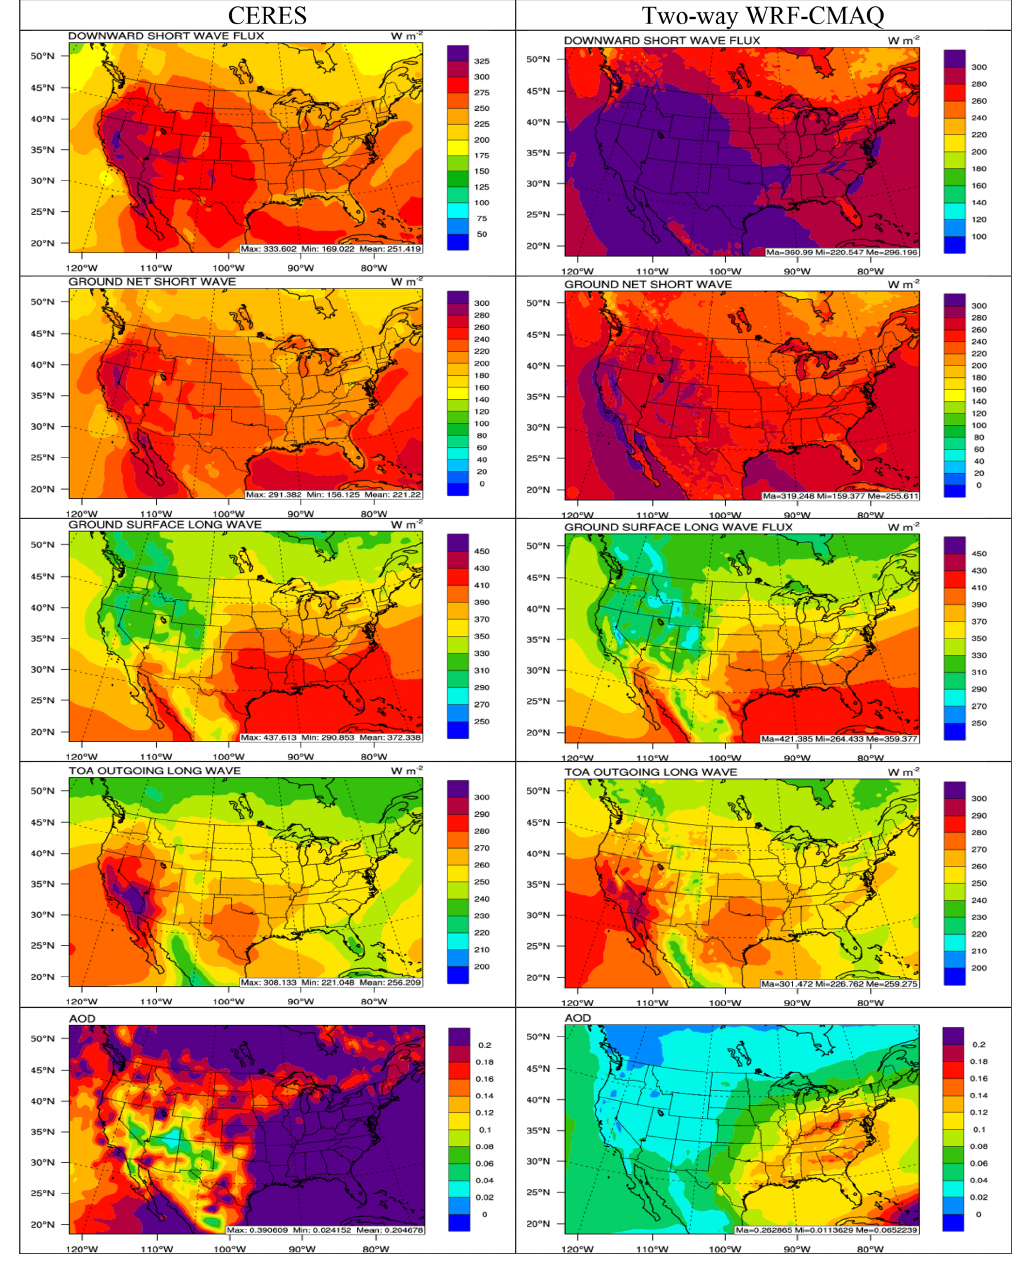
Figure 5. Spatial distribution of 5-year average major radiation variables (from top to bottom: SWDOWN, GSW, GLW, OLR, and AOD) between CERES observations (left column) vs. two-way WRF-CMAQ (right column) in summer